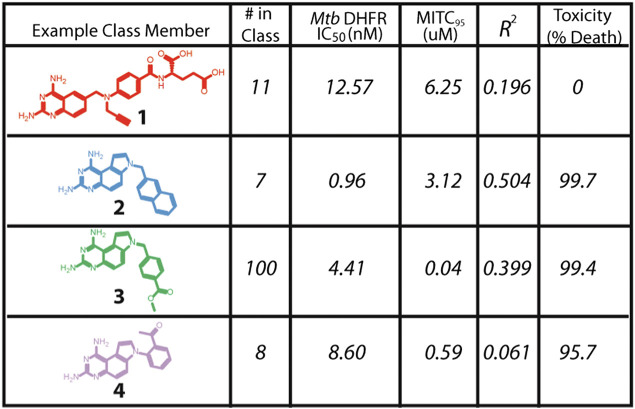
Novel inhibitors of DHFR with in vitro efficacy against M. tuberculosis. Adapted with permission from Santa Maria et al. (2017). Copyright (2017) American Chemical Society.